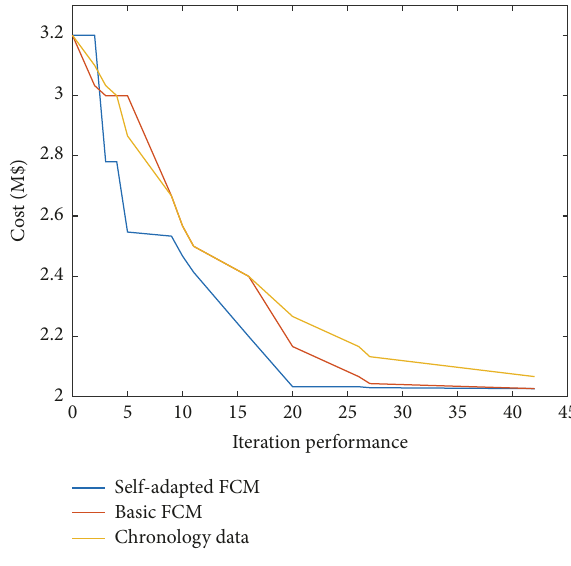
Figure 9: Iteration performance